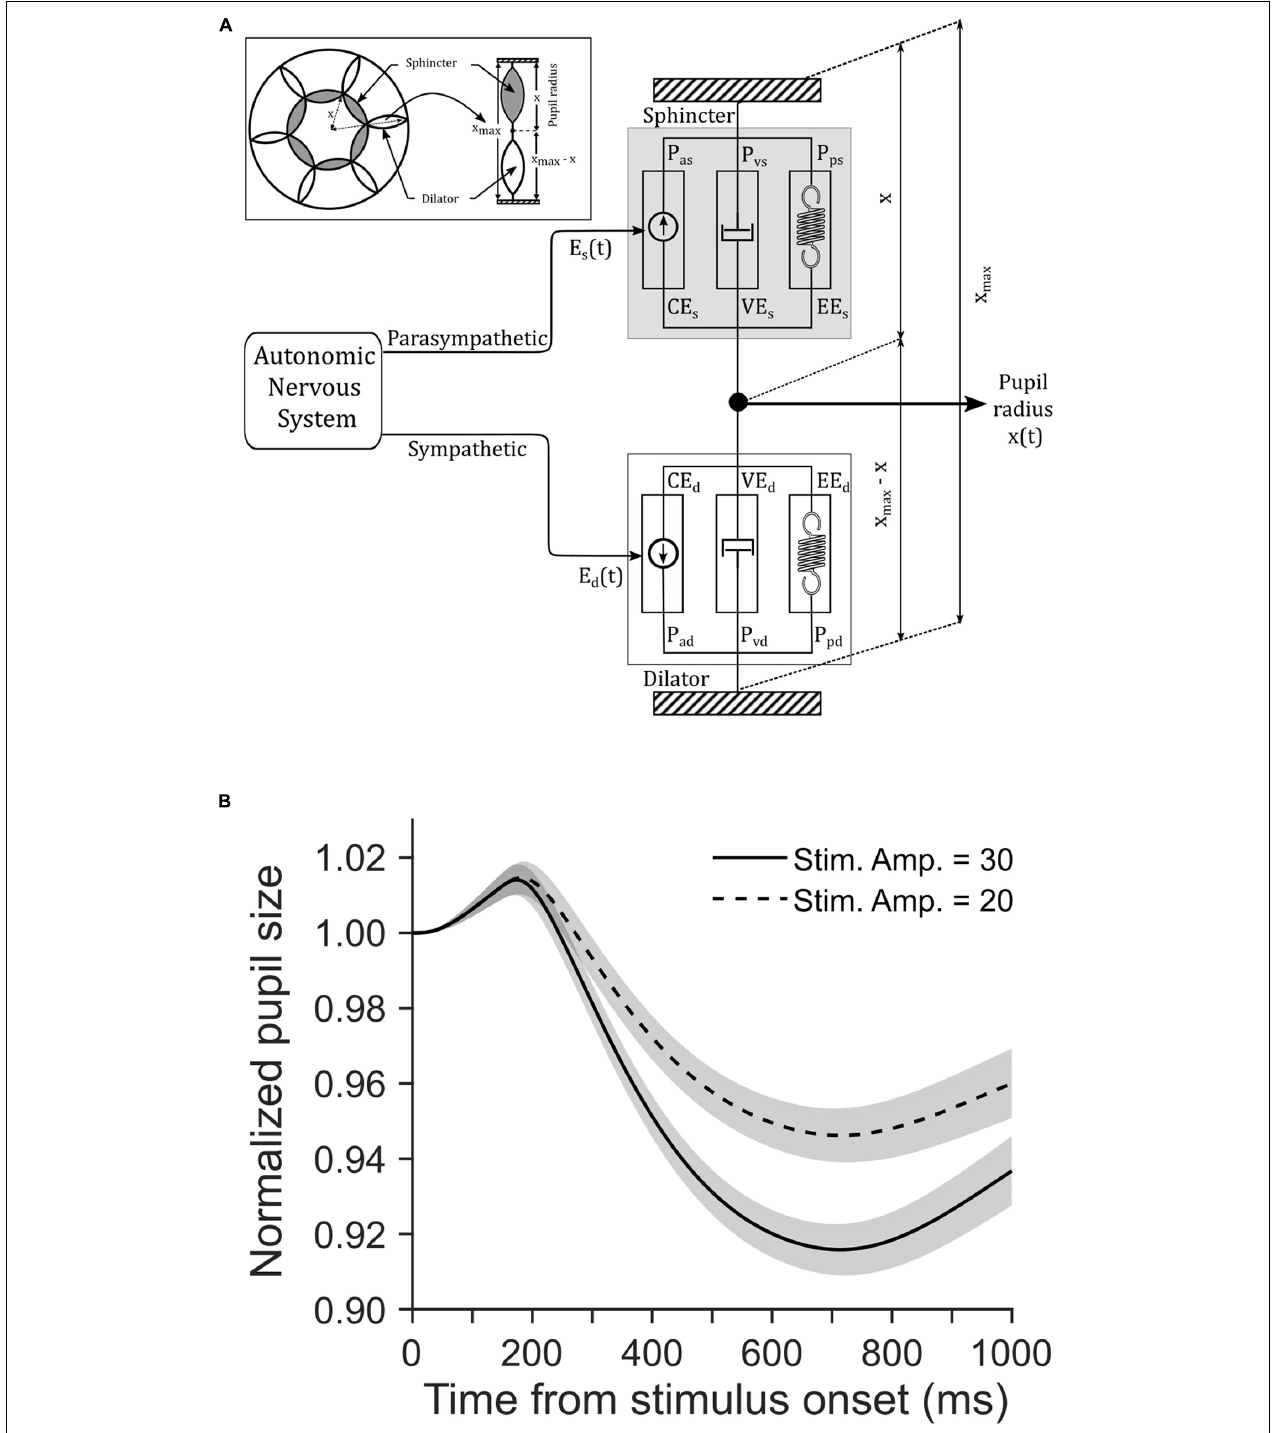
FIGURE 4 | (A) A schematic of Usui and Hirata (1995) model of pupillary muscle plants. The model determined the non-linear interactions between the dynamic properties of sphincter and dilator muscle components as they received inputs from the parasympathetic and sympathetic division of the autonomic nervous system (ANS), respectively. Refer the Supplementary Material and Table 1 for details of parameters. (B) The influence of stimulus strength on simulated pupil dynamics from stimulus onset. Simulation of a biomechanical model of pupillary aperture (Usui and Hirata, 1995) with the two different stimulus strengths yielded stimulus amplitudes of 30 (solid) and 20 (dashed). Simulated pupil dynamics mimic the behavioral data (see Figures 3A–C ). The gray patches are overlaid on the traces to show corresponding SE of the mean pupil size.